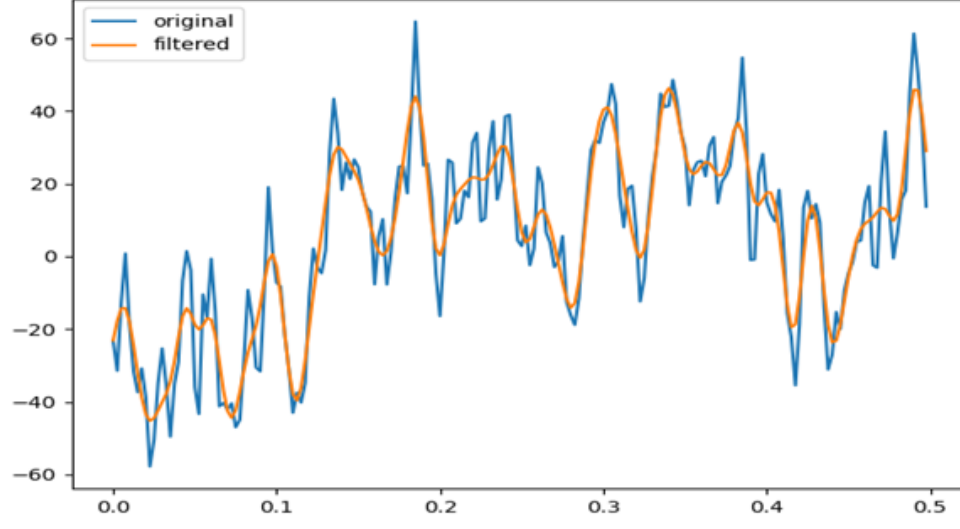
Figure 2. Butterworth low-pass filtering for noise removal